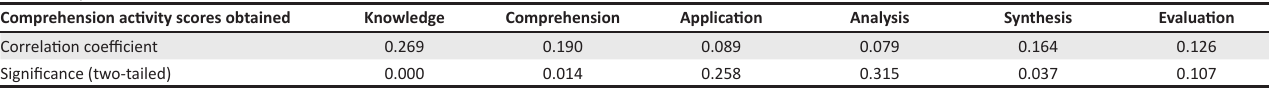
TABLE 4: Spearman’s correlation coefficient of variables. Comprehension activity scores